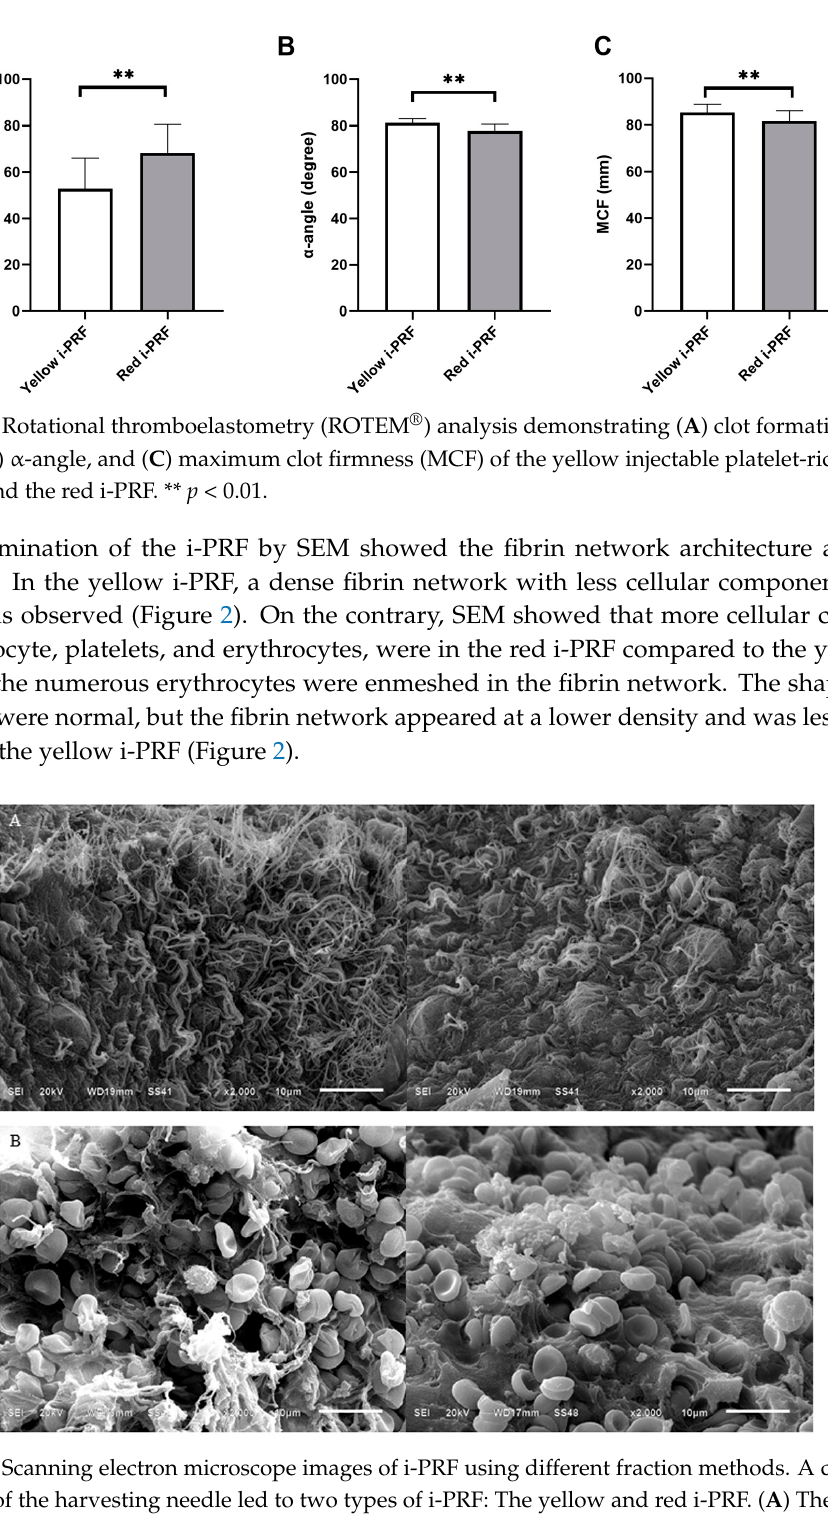
Figure 1. The CFT for the yellow i-PRF was shorter than the red i-PRF. The α -angle was higher in the yellow i-PRF compared to the red i-PRF. The MCF was also higher in the yellow i-PRF compared to the red i-PRF.